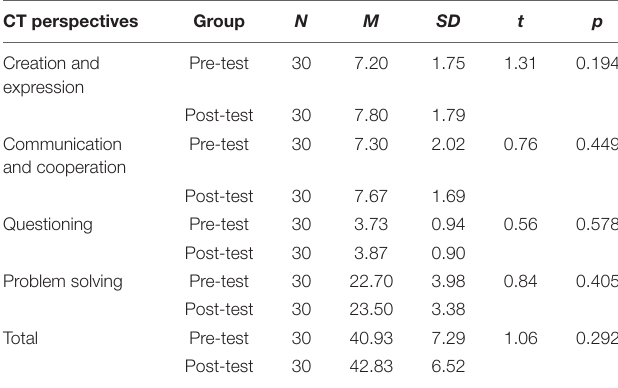
TABLE 13 | The paired sample t -test of the CG’s CT perspectives pre- and post-test.